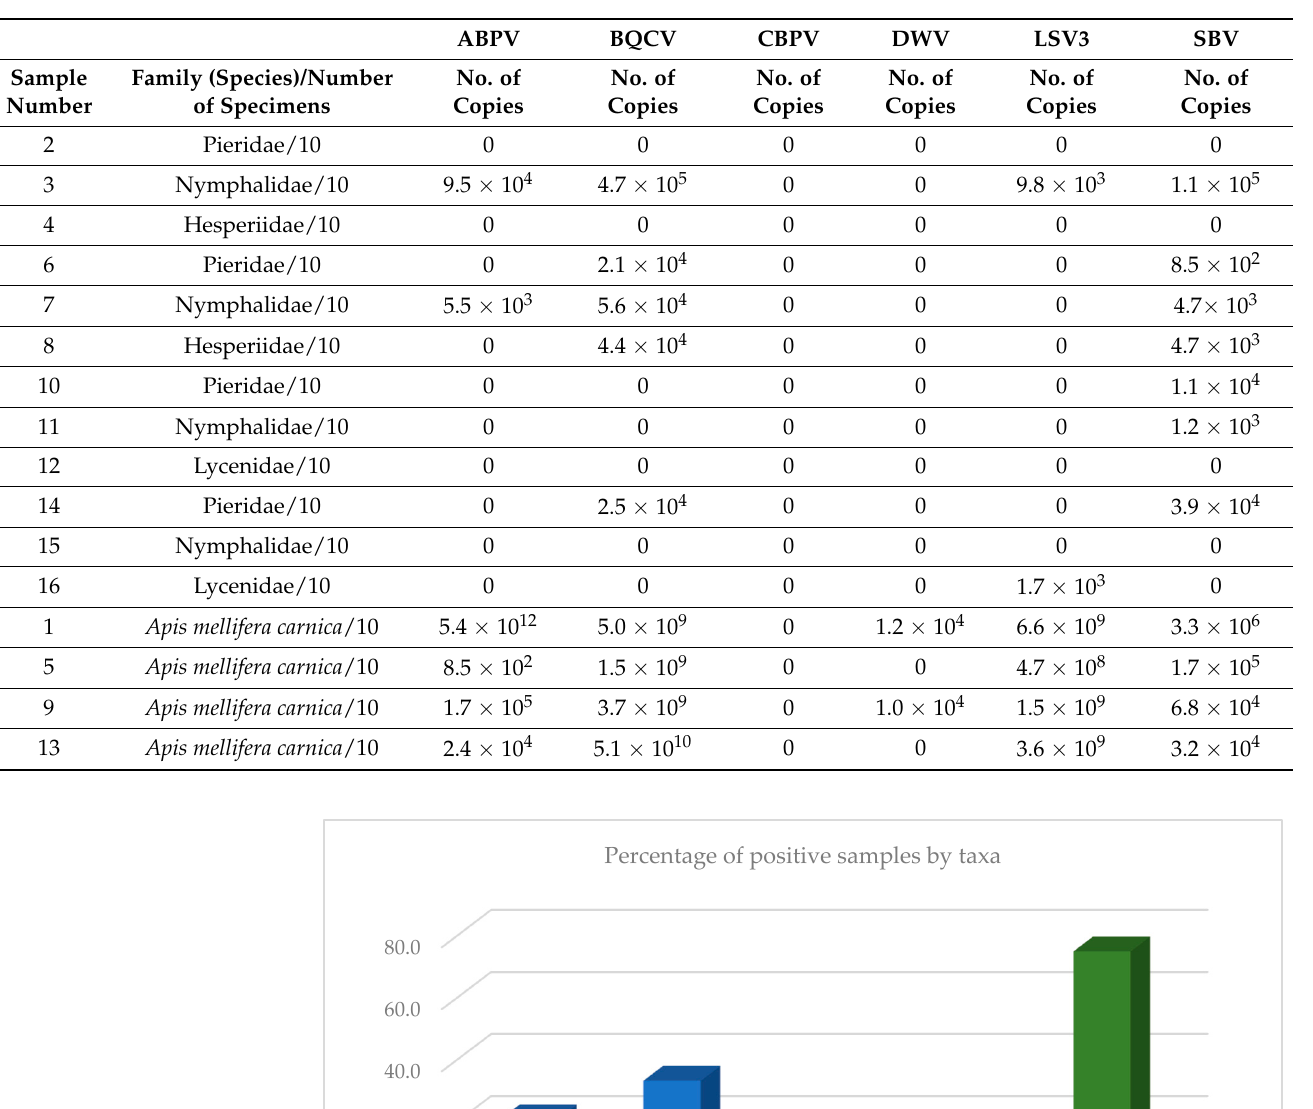
Table 2. Viral RNA copy number in each tested sample, which consisted of 10 butterflies/10 honey- bees for each virus individually.